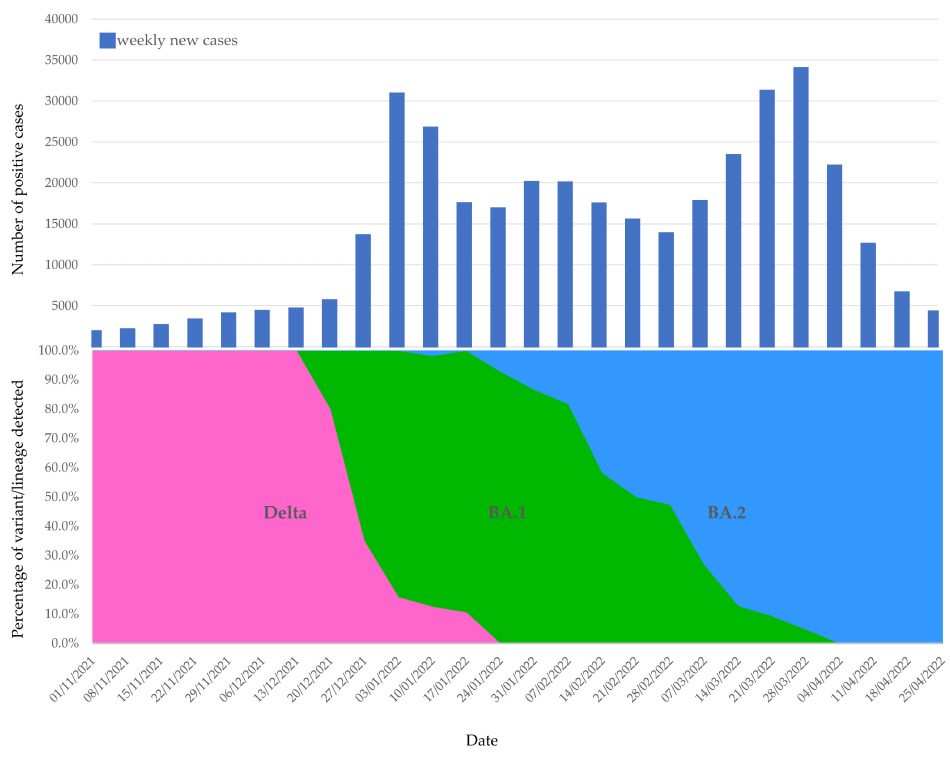
Figure 4. Time course of the frequency of the SARS-CoV-2 VOC identified in Cyprus in relation to the number of daily positive cases recorded between November 2021 and April